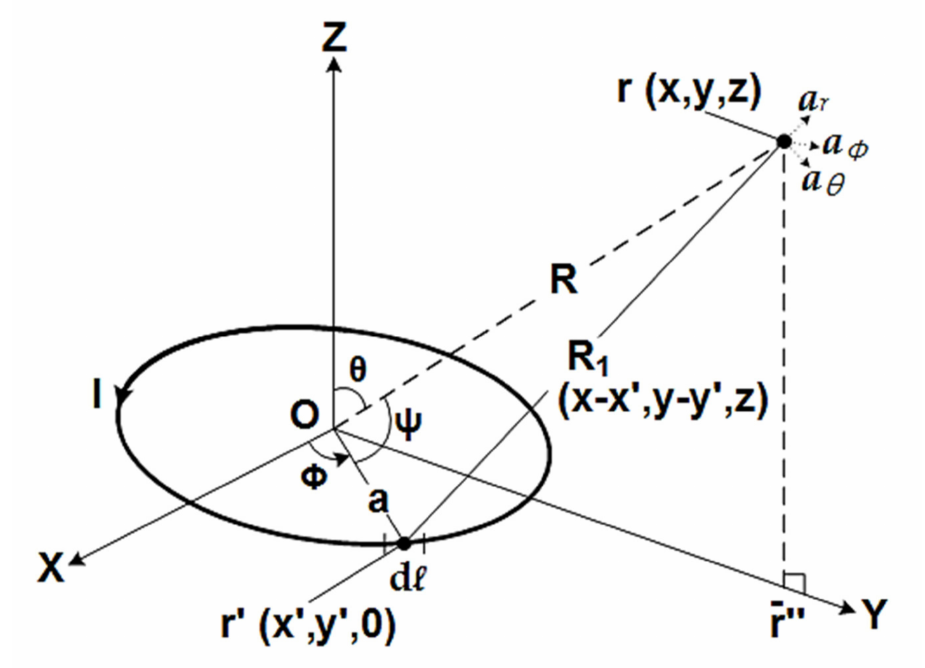
Figure 1. Model of the small circular loop with current I